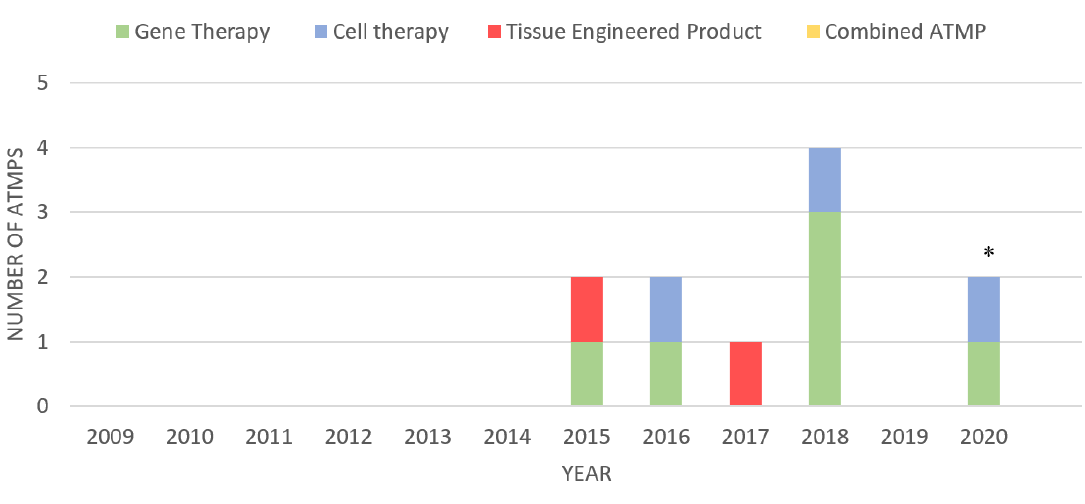
Figure 1. ATMPs (advanced therapy medicinal products; gene therapies, cell therapies, tissue-engineered products and combined ATMPs) that have been granted marketing approval by the EMA. Note: * indicates cell therapy “KTE-X19” expected to receive market authorization in 2020 (the EMA has validated their application but it currently under review [8,9]).